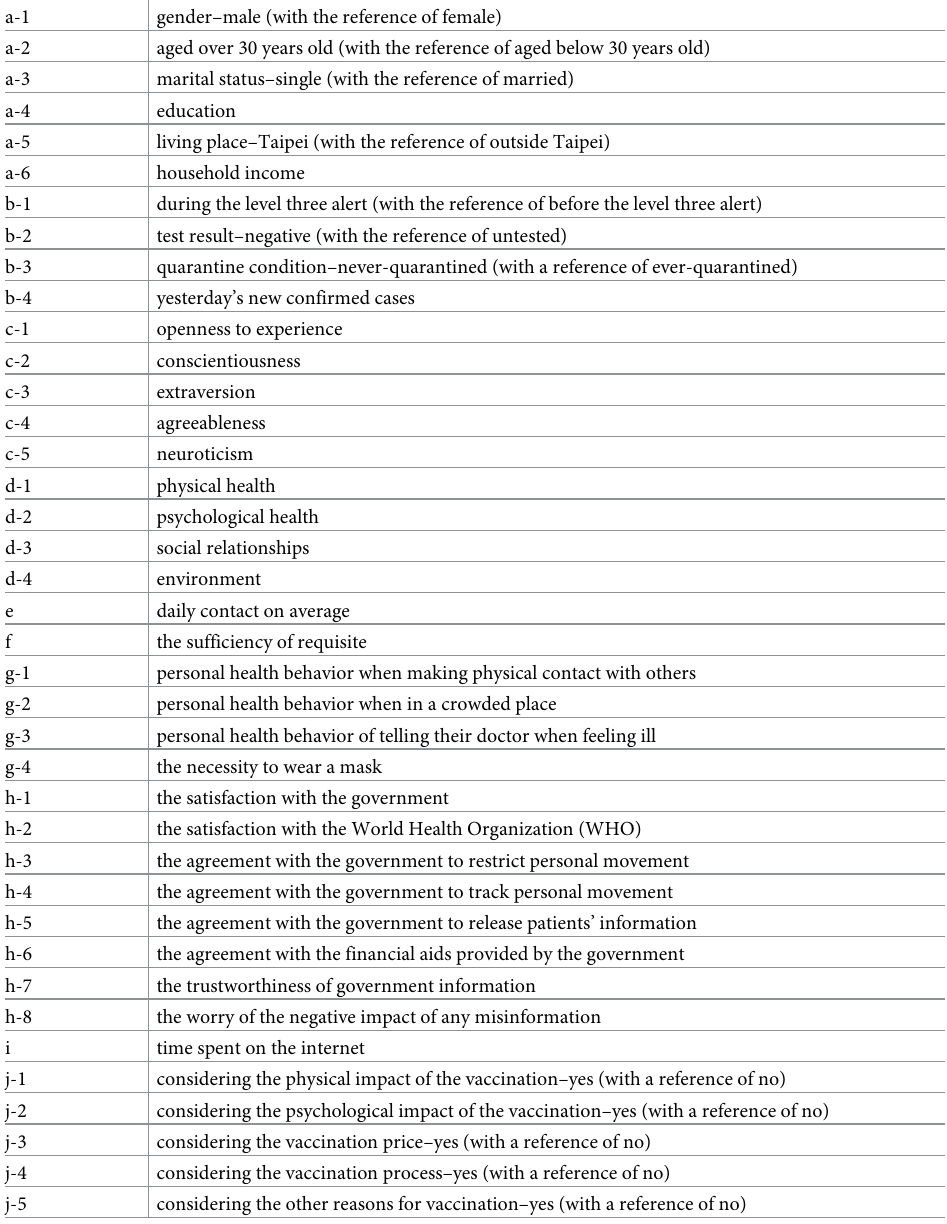
Table 1. All candidate variables in the full